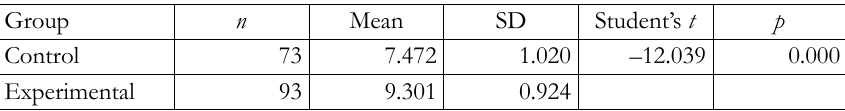
Table 3. Student’s t test in the control and experimental groups